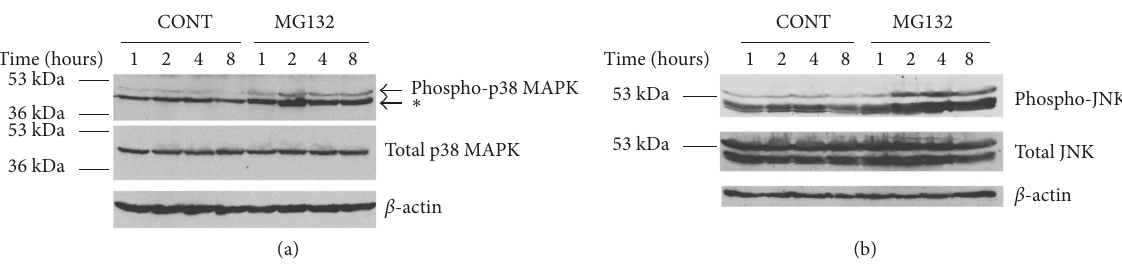
Figure 3: Proteasome inhibitor (MG132, 10 μ M) can activate p38 MAPK and JNK in RPE. (a) ARPE-19 cells were cultured in the absence or presence of the proteasome inhibitor MG132 (10 μ M) for 1, 2, 4, and 8h. Levels of endogenous phospho-p38 MAPK, total p38 MAPK, and actin were detected by Western blot using polyclonal (to phosphorylated and total p38 MAPK) and monoclonal antibodies (to actin). ∗ Is the only one phosphorylated site of P38 MAPK. (b) ARPE-19 cells were cultured in the absence or presence of the proteasome inhibitor MG132 (10 μ M) for 1, 2, 4, and 8h. Levels of endogenous phospho-JNK, total JNK, and actin were detected by Western blot using polyclonal (to phosphorylated and total JNK) and monoclonal antibodies (to